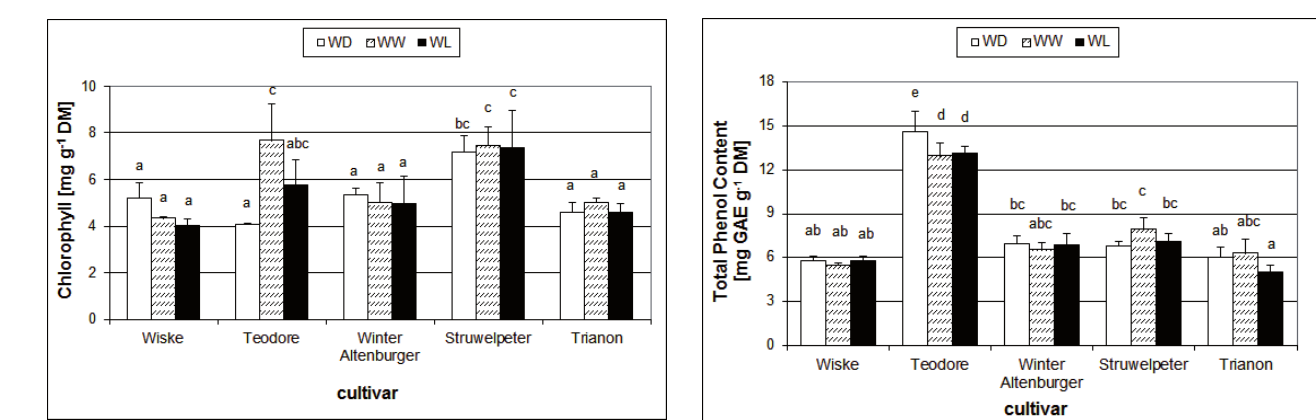
Fig. 4: Total Phenol Content [mg GAE g -1 DM] of different cultivars and varieties of Lactuca sativa spp. grown under different water regimes (water-deficit = 18-25 % [WD], well-watered = 50 % [WW], water- logged = 61-70 % [WL]). Data represent n ± SD. Bars with different letters were significantly different (Tukey-B test, p ≤